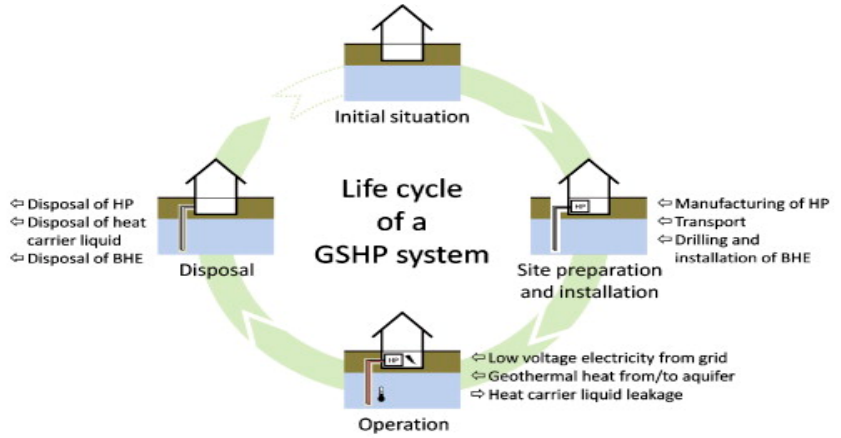
Figure 3. Life cycle stages of a GSHP system and the main flows of unit processes contributing to the whole life cycle [15].